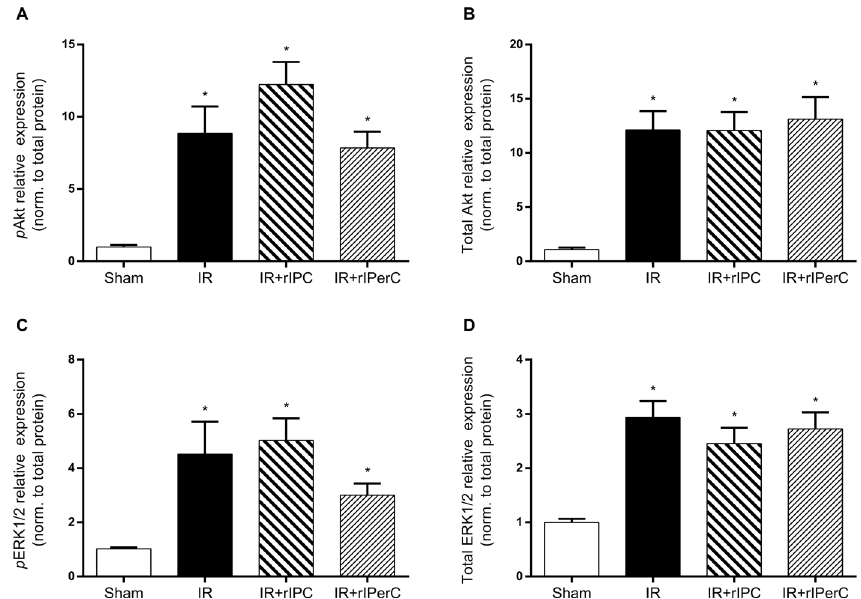
Fig 5. Effect of ischemia-reperfusion injury and remote ischemic conditioning on protein expression levels of phosphorylated and total protein kinase B (Akt) and extracellular signal-related kinase 1/2 (ERK1/2) protein levels. A) Phosphorylated protein kinase B (pAkt). B) Total protein kinase B (Akt). C) Phosphorylated ERK1/2 (pERK1/2). D) Total ERK1/2. Bars represent protein level by western blotting normalised to total protein. All values are expressed as mean ± SEM. Group means were compared using one-way analysis of variance followed by Bonferroni ’ s multiple comparison post-test. * P < 0.05 vs. sham. Number of animals: sham (n = 7), ischemia-reperfusion (IR; n = 10), IR and remote ischemic preconditioning (IR+rIPC; n = 10), IR and remote ischemic perconditioning (IR+rIPerC; n = 10).